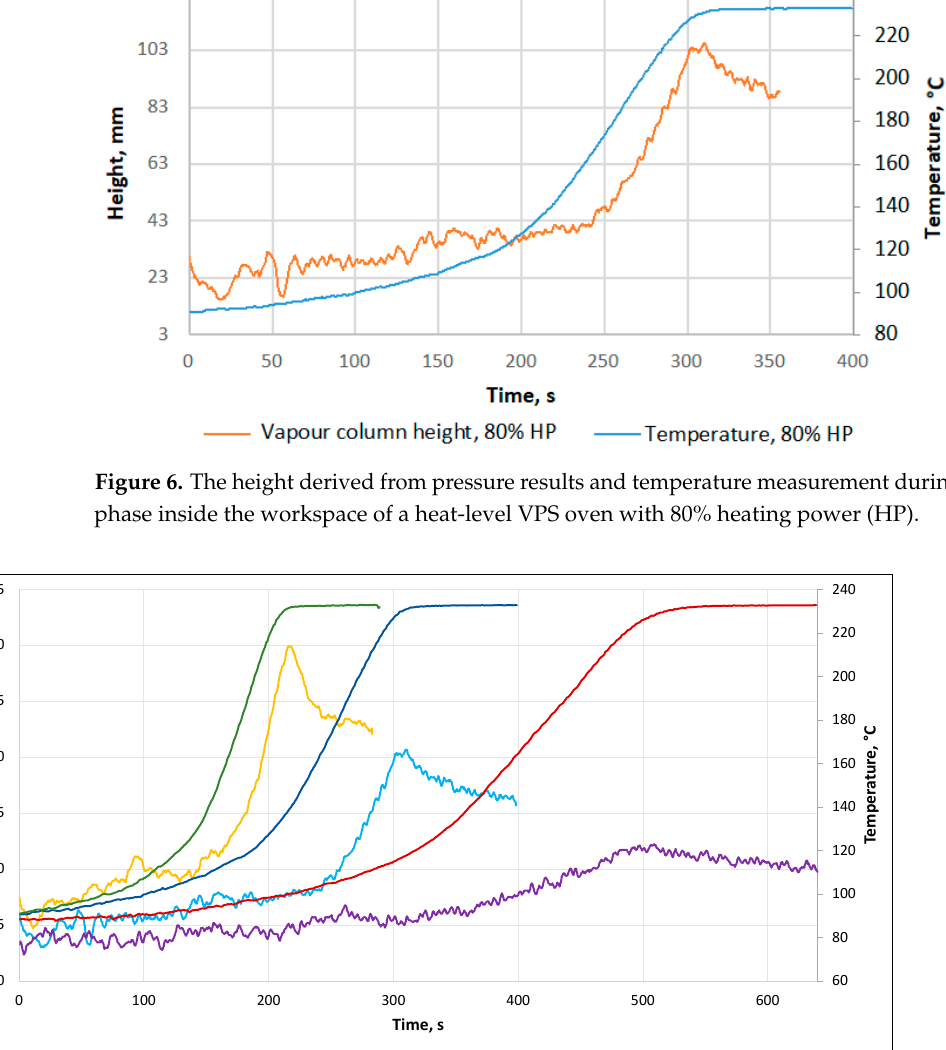
Figure 6. The height derived from pressure results and temperature measurement during the heat- ing phase inside the workspace of a heat-level VPS oven with 80% heating power (HP).